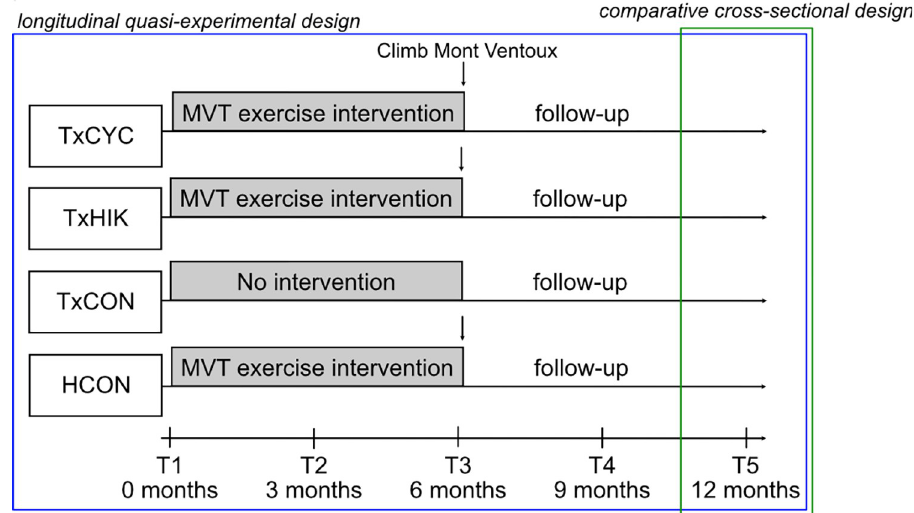
Fig 2. Hybrid study design. The present study combines a quasi-experimental design for longitudinal follow-up of physical activity, health-related quality of life, mental health, depressive symptomatology, anxiety, and stress with a cross-sectional design to compare barriers and facilitators to physical